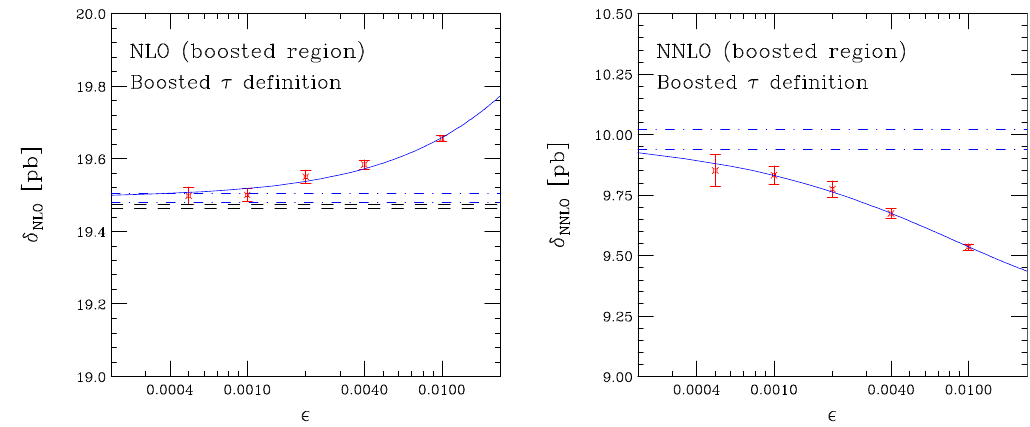
Figure 8 . (cid:28) -dependence of NLO (left) and NNLO (right) coe(cid:14)cients for Higgs boson production in the boosted regime, p H > 450 GeV. The (blue) solid lines correspond to the (cid:12)t forms in eqs. (3.4) T and (3.5), with the dot-dashed lines representing the errors on the asymptotic value of the (cid:12)t. For the NLO coe(cid:14)cient the exact result computed in MCFM using dipole subtraction is shown as the black dashed